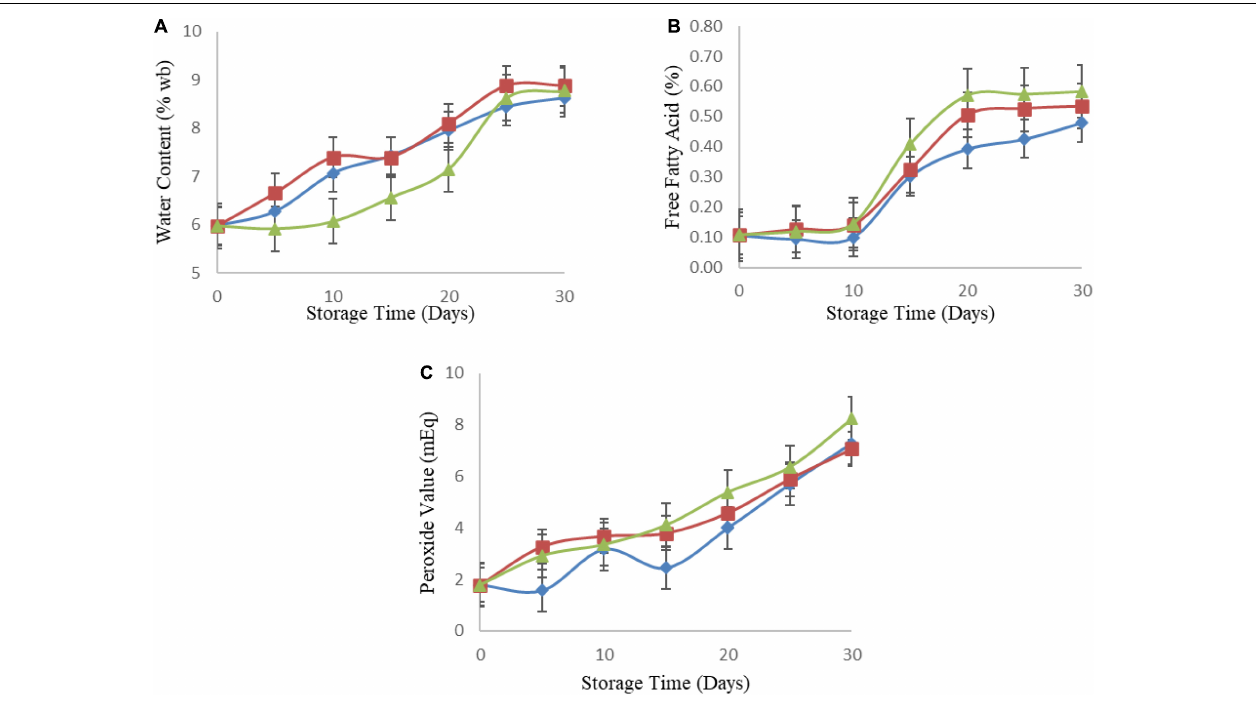
FIGURE 1 | Change in water content (%wb) (A) , free fatty acid (%) (B) , peroxide value (mEq) (C) , during storage at 27, 37, and 47 ◦ C. ( (cid:7) = 27 ◦ C), ( (cid:4) = 37 ◦ C), and ( (cid:78) = 47 ◦ C). Error bar is standard error. n = 4 (2 experiments × 2 replications) for water content, free fatty acid and peroxide number.